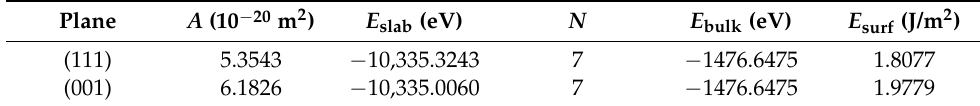
Table 1. Surface energies calculated by the first-principles equation.